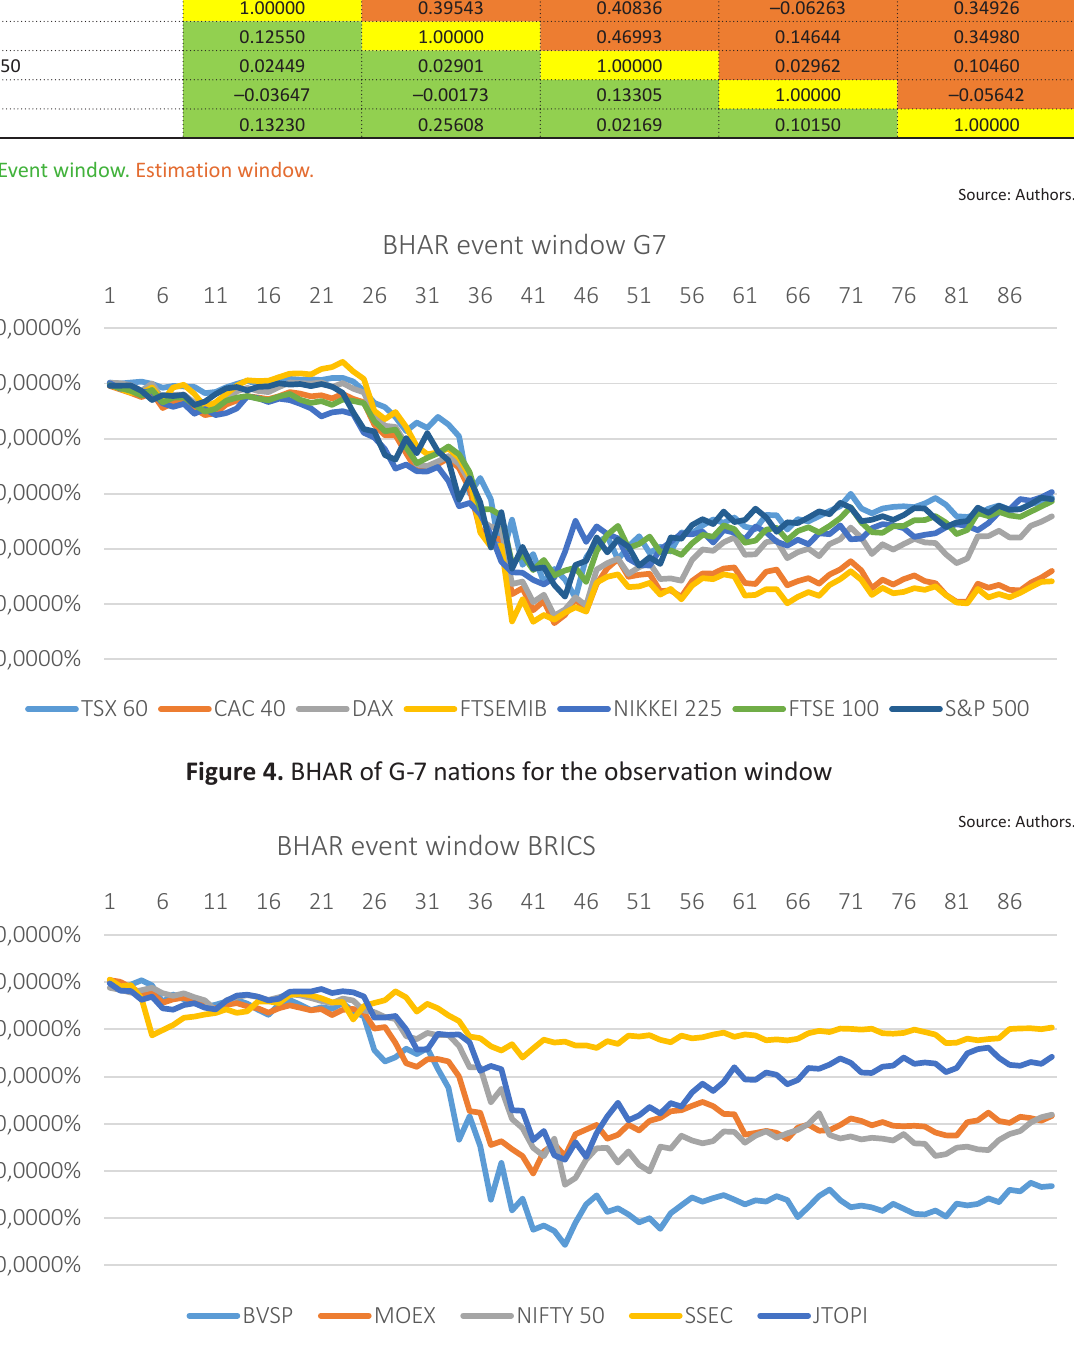
Figure 5. BHAR of BRICS nations for the observation window (Table 10) for their intergroup and intra-window comparison. The observation window witnesses an increased correlation compared to the estimation